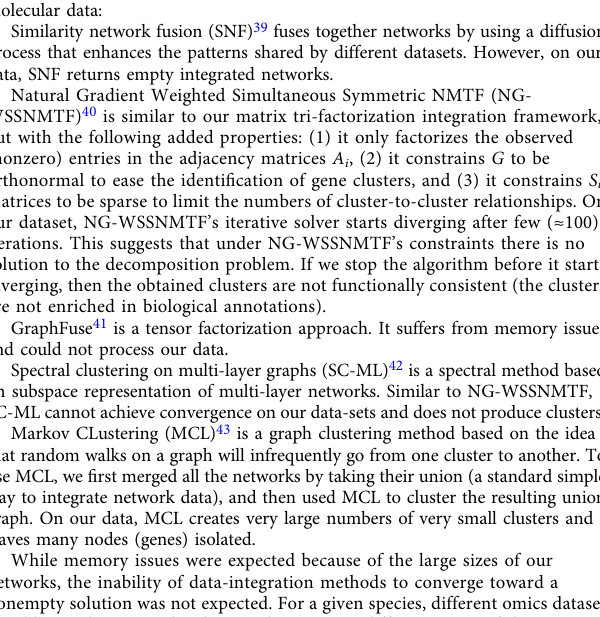
Table 2 Top 20 pan-cancer least rewired genes Rank